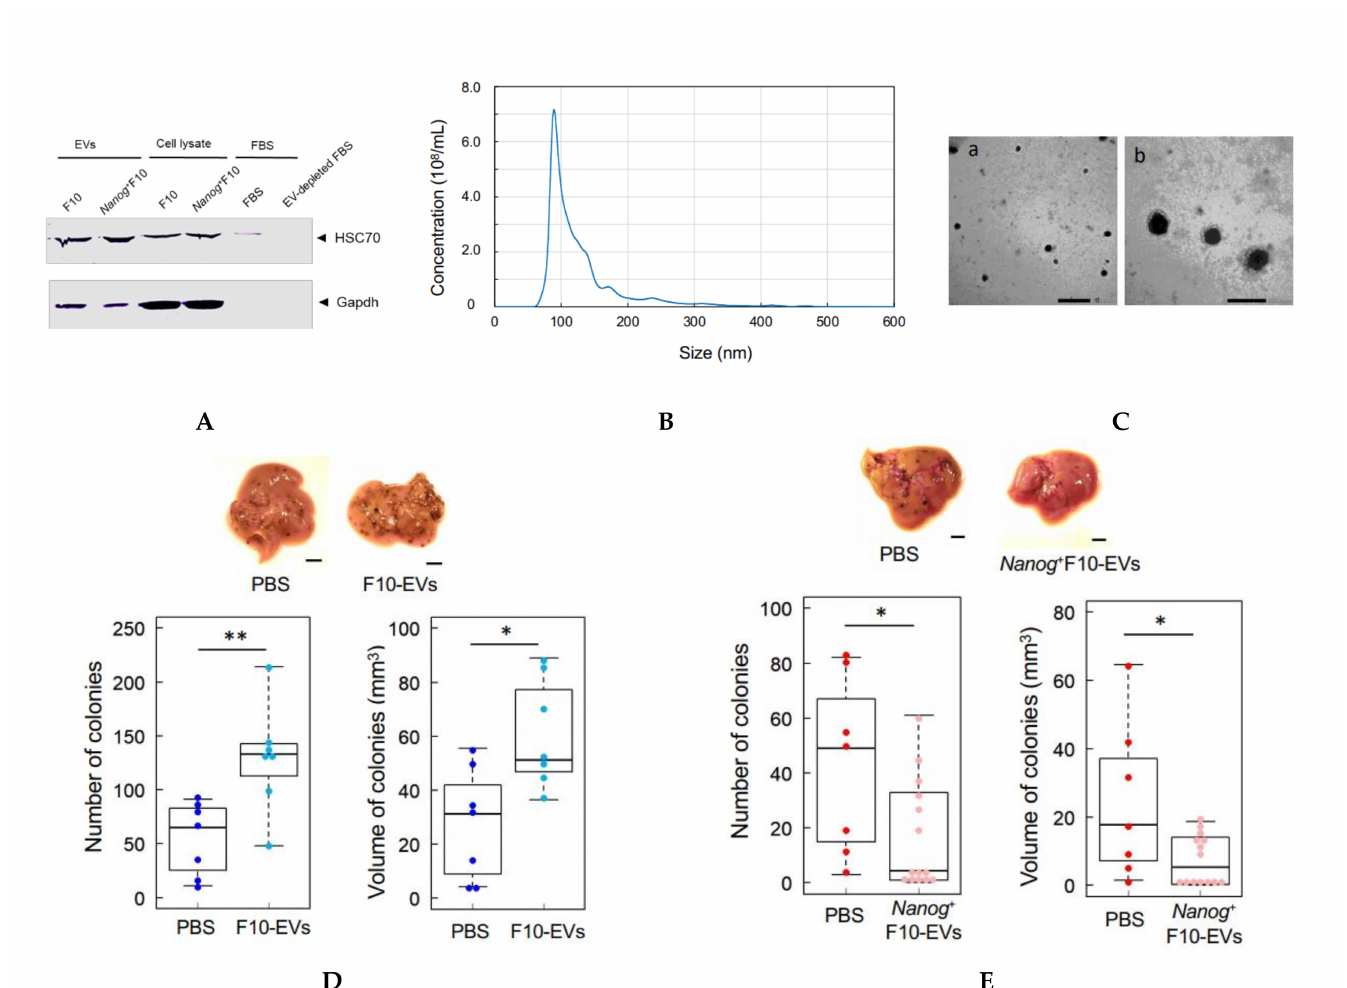
Figure 2. Comparison of the effects of pre-administration of F10-EVs and Nanog + F10-EVs in mice on the metastasis. ( A ) Western analysis of HSC70 protein in EVs and EV-depleted FBS. The lane of EV-depleted FBS is a sample of FBS after ultracentrifugation at 100,000 g × 80 min twice. ( B ) Particle size distribution of EVs determined by NanoSight analysis. Concentration: 3.07 × 10 10 ± 0.06 parti- cles/mL, Mode diameter: 90.0 ± 0.7 nm, mean diameter: 130.1 ± 1.0 nm, n = 5. ( C ) TEM photographs of EVs. Scale bars: (a) 500 nm, (b) 200 nm. ( D ) Effects of pre-administration of F10-EVs and PBS on the images, number, and volume of metastatic colonies after injection of F10 cells. Scale bar, 5 mm; n = 7. ( E ) Effects of pre-administration of Nanog + F10-EVs and PBS on the images, number, and volume of metastatic colonies after injection of Nanog + F10 cells. Scale bar, 5 mm; n = 14 for Nanog + F10-EVs, n = 7 for the control (PBS). The image of (A) was cropped from red dotted lines on full-length gel image shown in Supplementary Figure S4. **: p < 0.01, *: p <